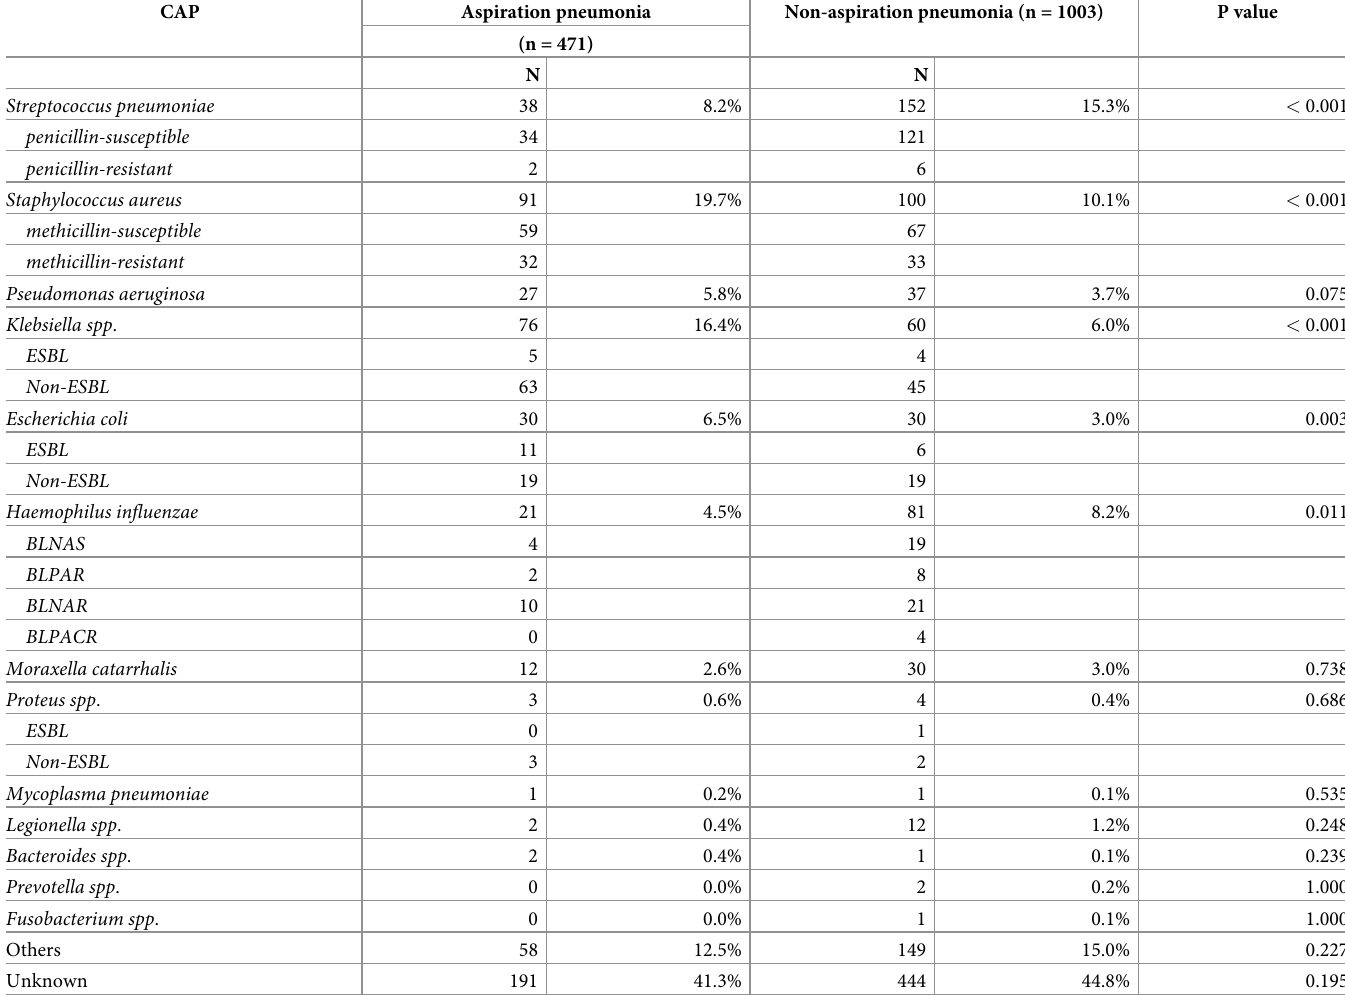
Table 6. Pathogen distribution in community-acquired pneumonia